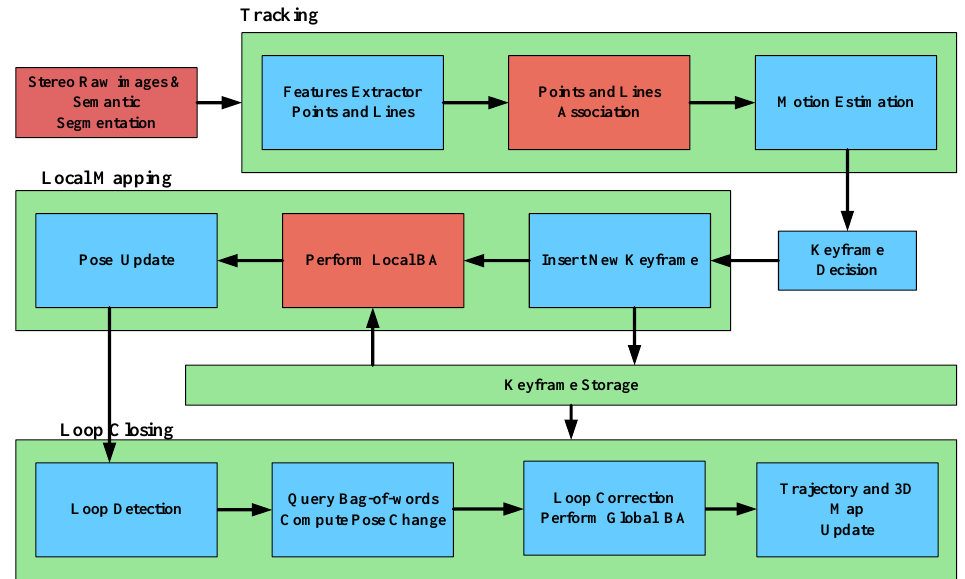
Figure 3. System overview. Our system pipeline is an extension of the ORB-SLAM2 [9]. In the figure, the red squares are the main improved modules in our approach. Our system is composed of three main threads: Tracking, Local Mapping, and Loop Closing. The tracking thread performs pose estimation by data association of point and line features. The local mapping thread adds the new keyframe into the map and optimizes it with BA. The loop closing thread constantly checks for loops and corrects them.